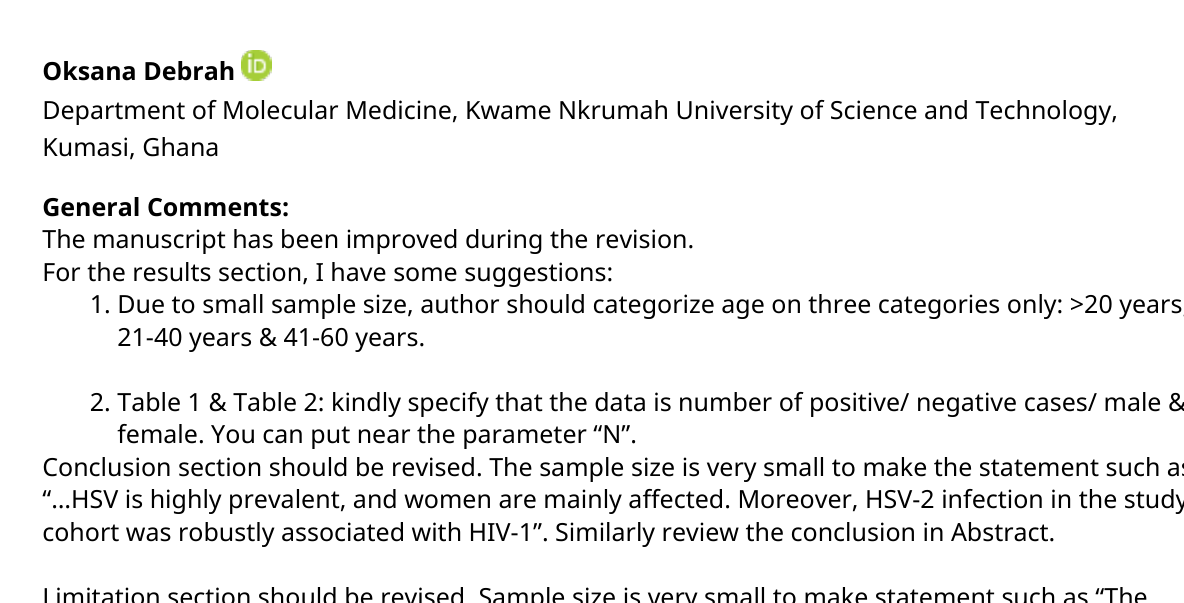
Table 1 & Table 2: kindly specify that the data is number of positive/ negative cases/ male & female. You can put near the parameter